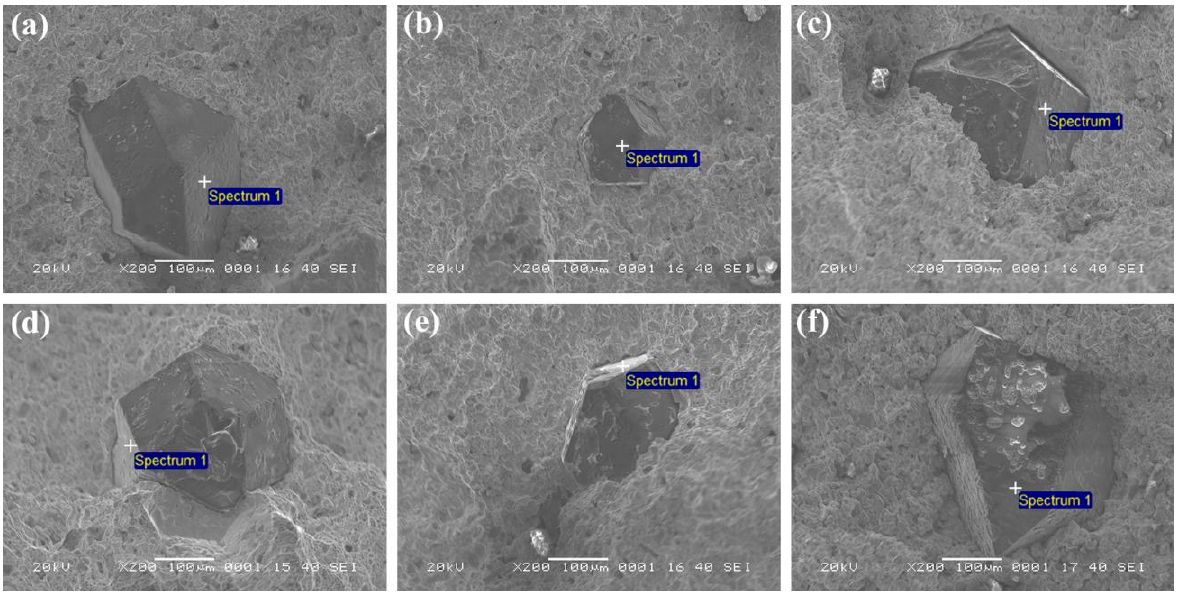
Figure 9. The bending fracture morphologies of diamond tools under pre-alloyed powders with different Ni contents: ( a ) T1: Ni-free, ( b ) T2: with 3 wt.% Ni, ( c ) T3: with 6 wt.% Ni, ( d ) T4: with 9 wt.% Ni, ( e ) T5: with 12 wt.% Ni, ( f ) T6: with 15 wt.% Ni.